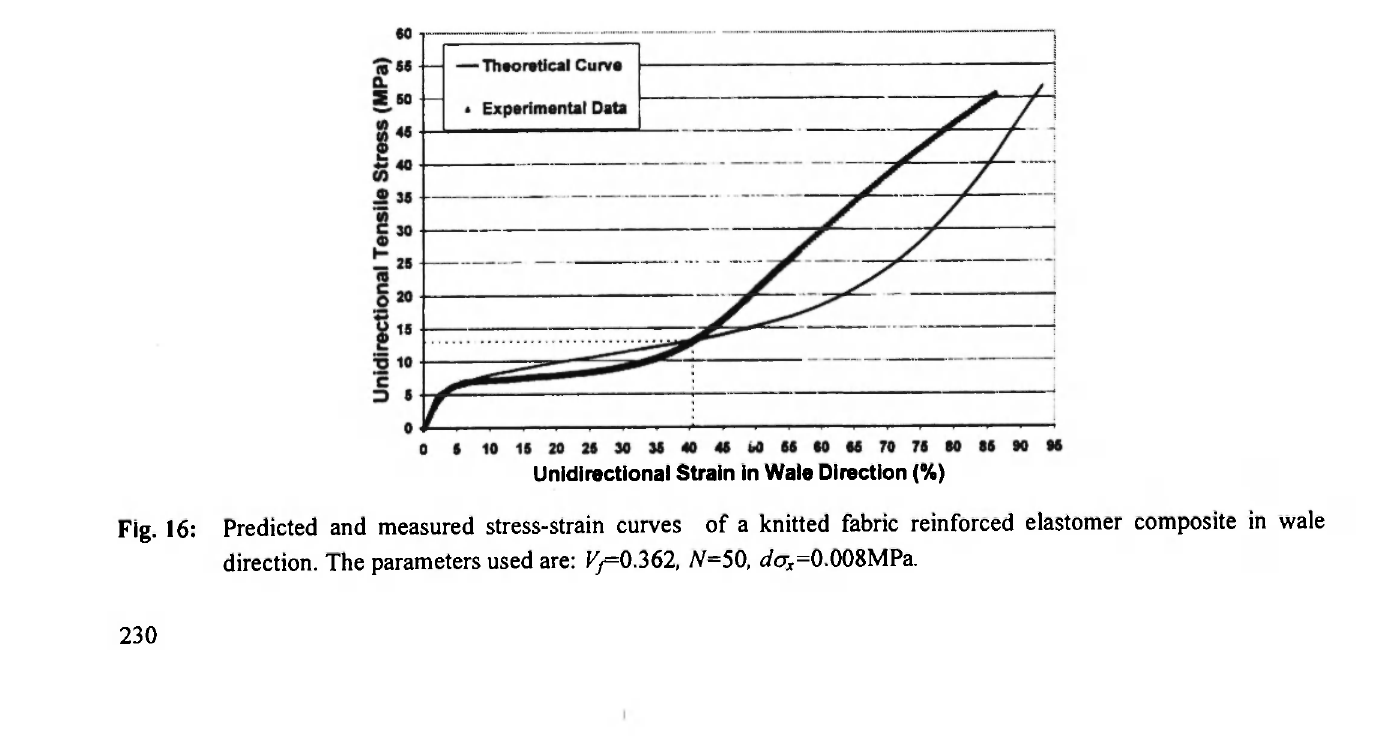
Fig. 16: Predicted and measured stress-strain curves of a knitted fabric reinforced elastomer composite in wale direction. The parameters used are: K/=0.362, /V=50,